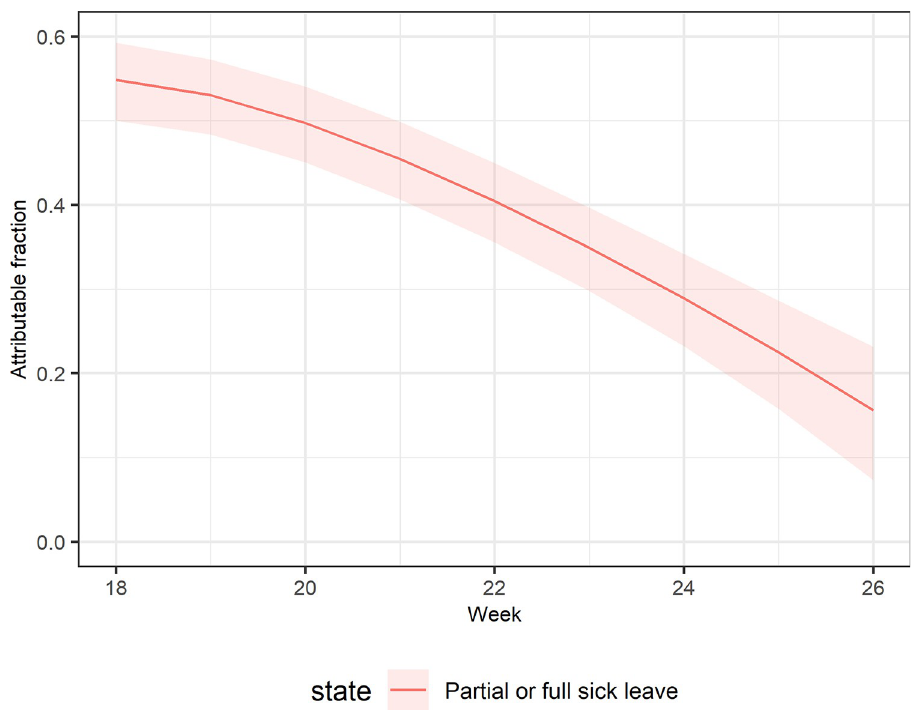
Fig 4. Attributable fraction of sick leave due to COVID-19 by calendar